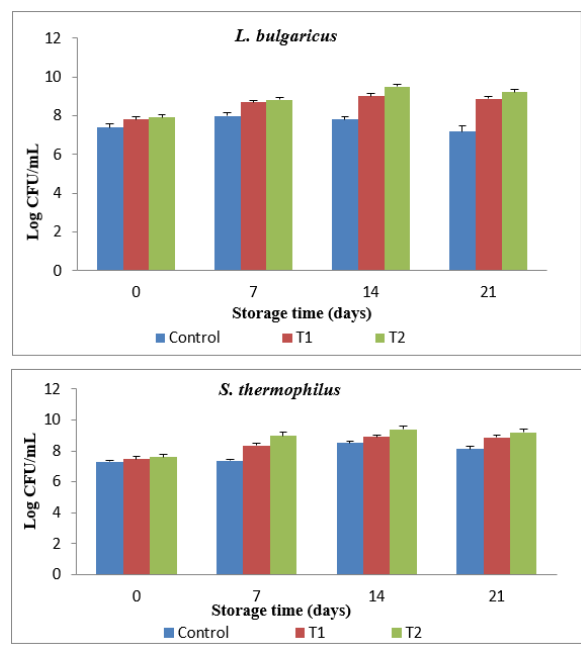
Figure 3: Counts of starter cultures in stirred yoghurt treatments during storage period. Control: plain yoghurt; T1: yoghurt containing 20 mg crude fucoxanthin / kg milk; T2: yoghurt containing 30 mg crude fucoxanthin / kg milk. Data are expressed as a mean of three replicates ± SD.